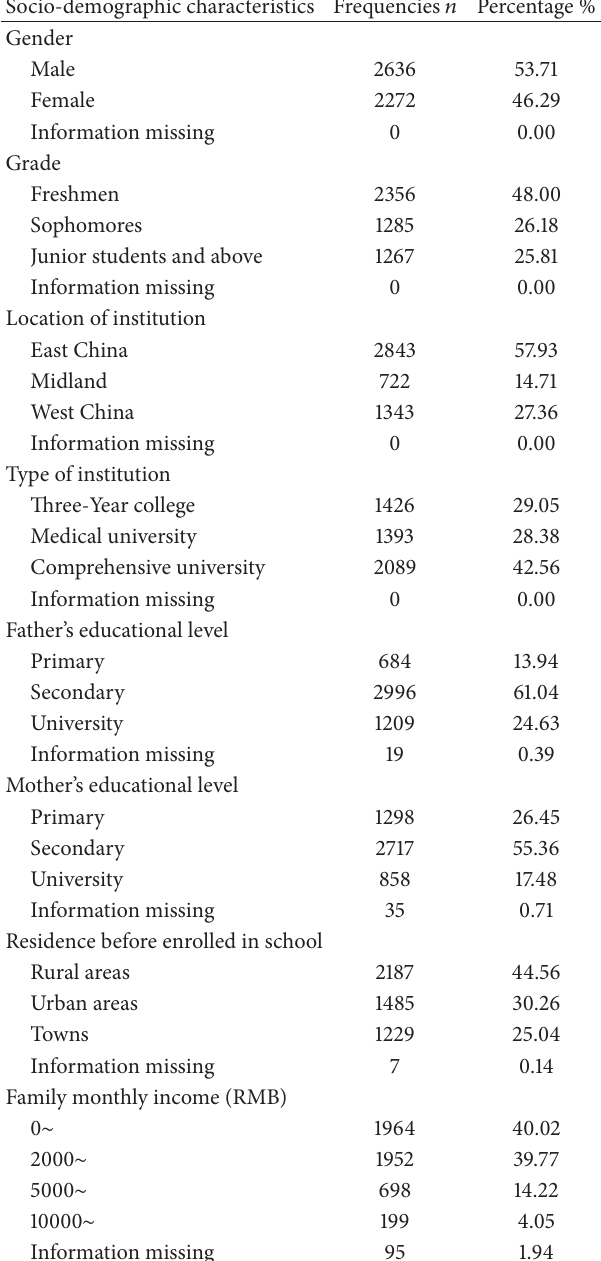
Table 1: Socio-demographic characteristics of the sample ( 𝑛 = 4, 908